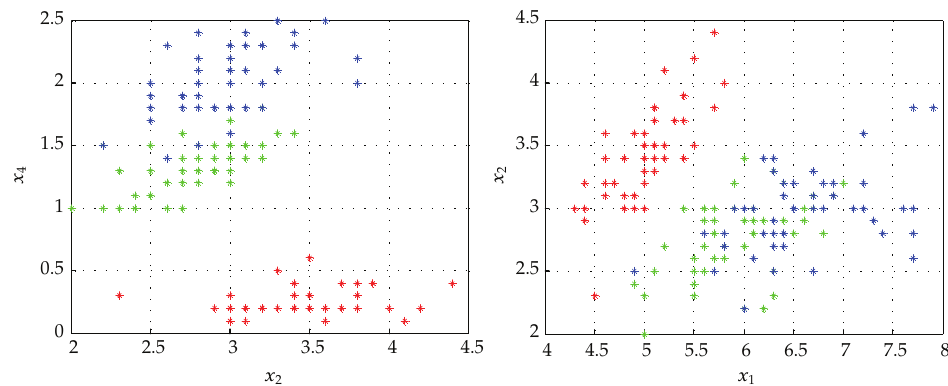
Figure 12: The Iris data figures for dimensions x 2 − x 4 and x 1 − x 2 .